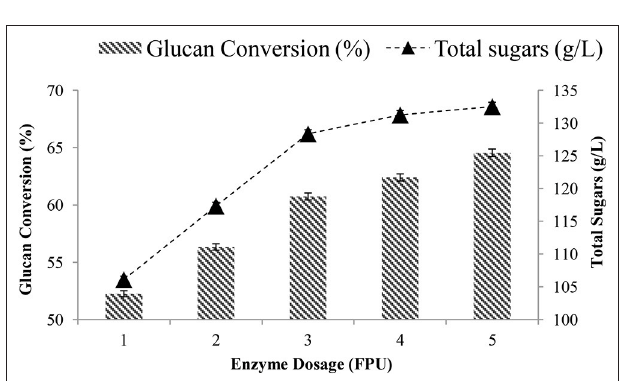
FIGURE 2 | Glucan conversion and total sugars obtained at various enzyme dosages (1–5 FPU/g TS) at 20% TS after